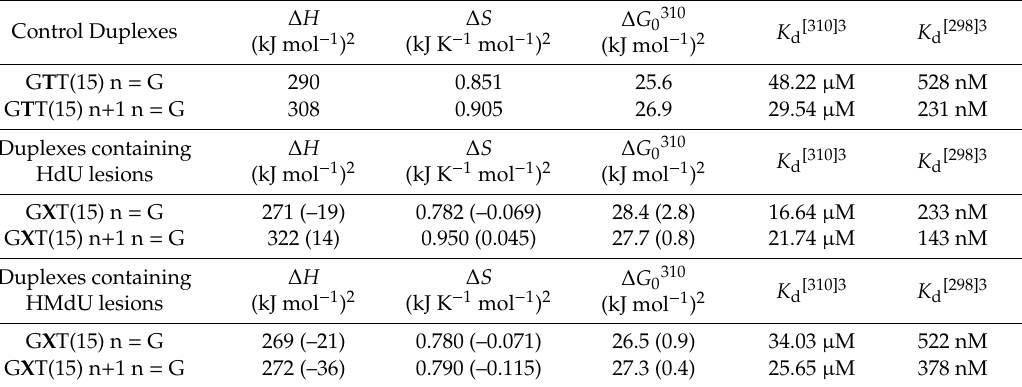
Table 2. MST-derived thermodynamic parameters of dissociation of duplexes formed between the 15mer DNA templates G T T(15) and G X T(15) (X = HdU or HMdU) and the matched or mismatched primers n or n + 1, where n = G nucleotide.